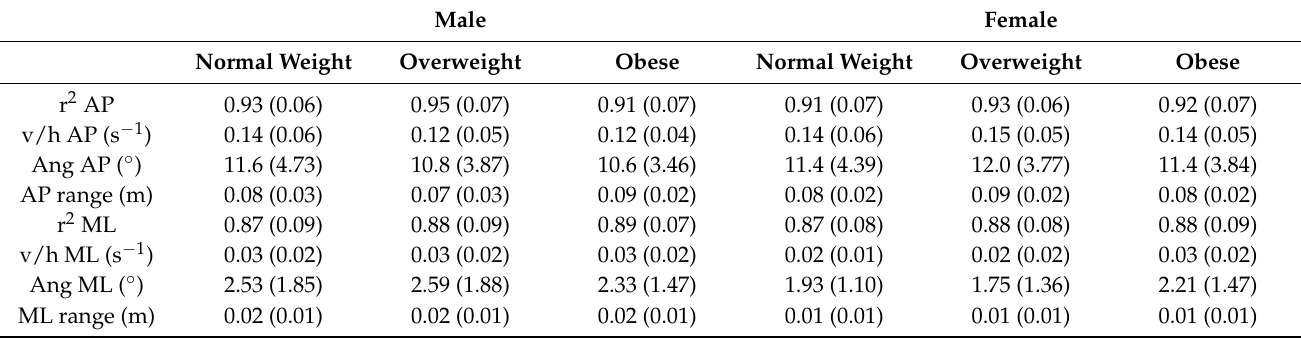
Table 5. Mean and standard deviation values of parameters extracted from the CoP in the antero– posterior (AP) and medio–lateral (ML) directions for young adults with Down syndrome and flat feet divided into males and females and according to weight class (normal weight, overweight, and obese). r 2 , coefficient of determination; v/h, mean CoP velocity normalized with respect to height; Ang, angle of inclination of the line interpolating the analyzed CoP displacement trait; range, range of the CoP (max coordinate–min coordinate). Male Female Normal Weight Overweight Obese Normal Weight Overweight